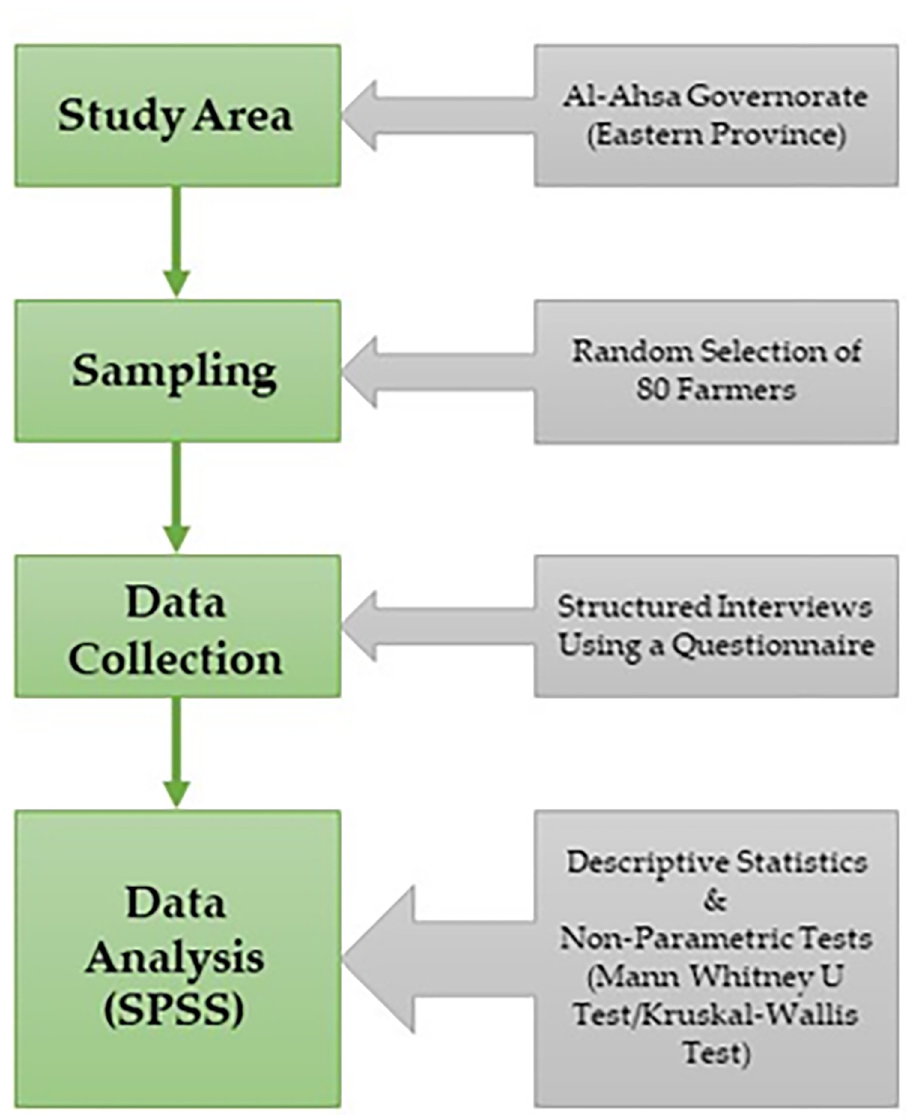
Fig 2. Methodological